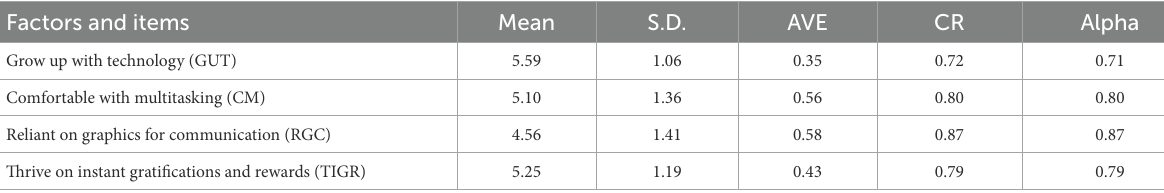
TABLE 1 The reliability of chinese digital natives assessment scale. Factors and